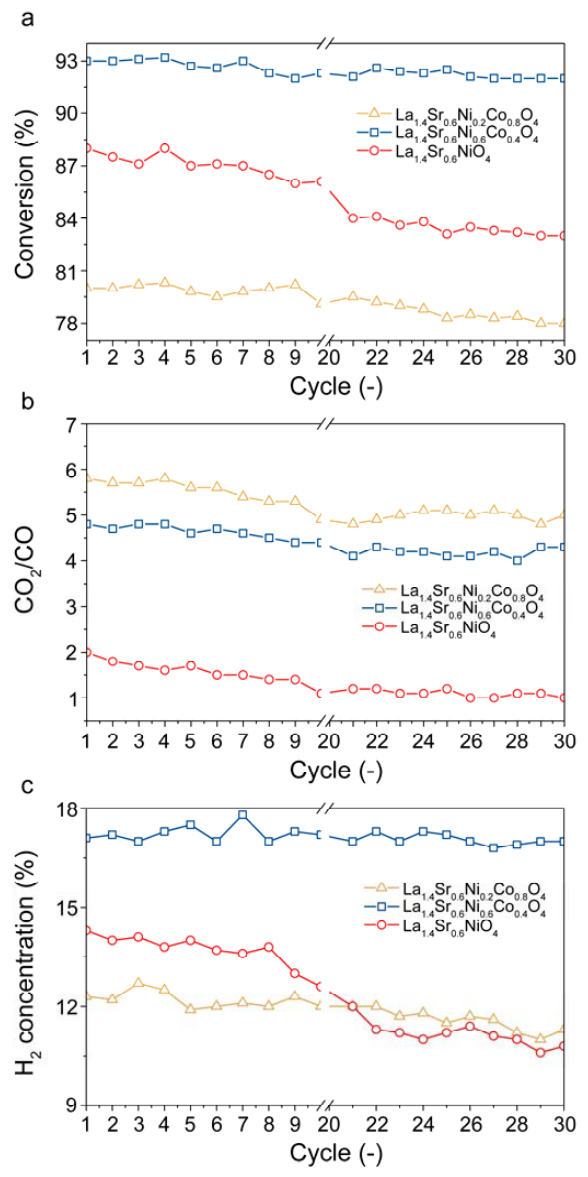
Figure 7. ( a ) Ethanol conversion, ( b ) CO 2 /CO and ( c ) H 2 concentration during stability tests.